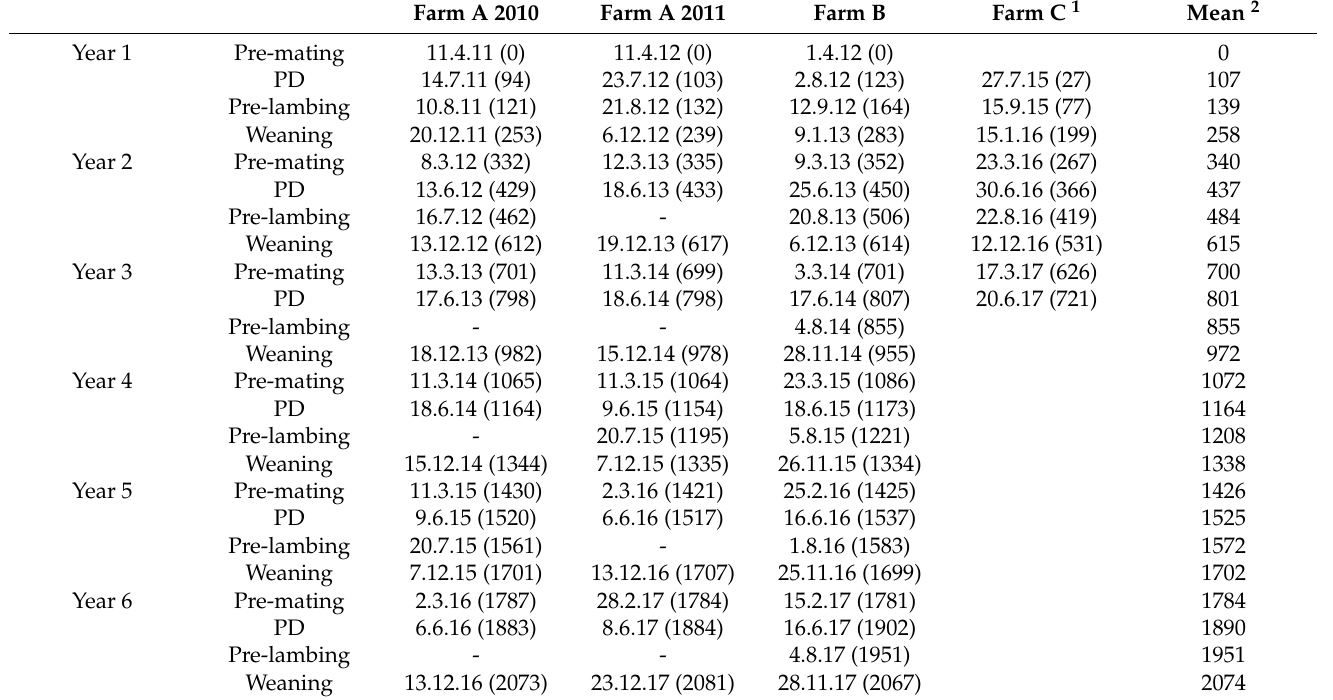
Table A1. Summary of timing of each of the data collection visits, for each cohort of ewe (Farm A 2010-born, Farm A 2011-born, Farm B and Farm C) in a longevity study, with reference to: year-of-age (Years 1–6), management visit within each year (pre-mating, pregnancy diagnosis (PD), pre-lambing and weaning), calendar date, and time in days since enrolment (in brackets).